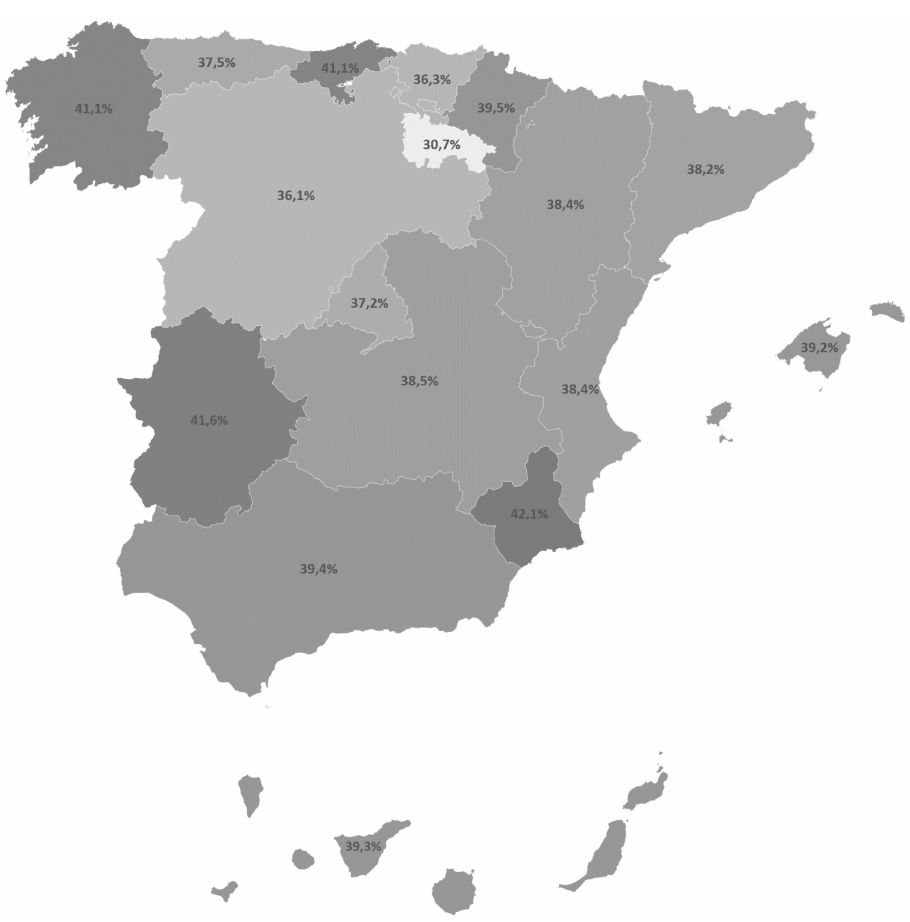
Figure 1. Frequency of Obstetric Violence (OV) per SAC.